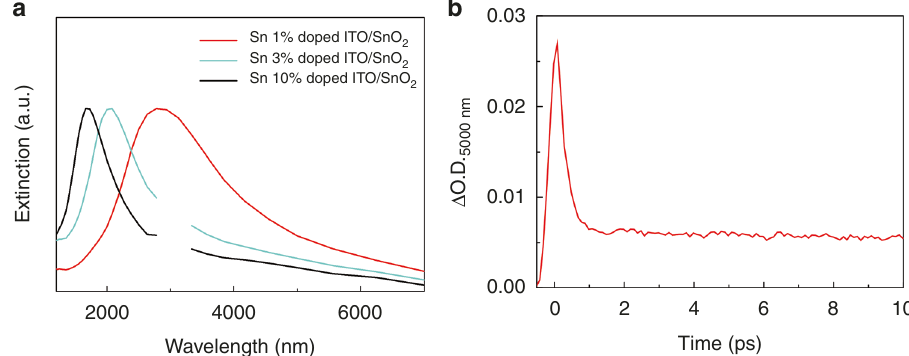
Fig. 3 Extinction spectra and kinetic pro fi les. a Extinction spectra of heterointerfaces between ITO NCs with different Sn-doping ratios and SnO 2 . The gaps at around 3000 nm of the 10%-Sn-doped ITO/SnO 2 or 3%-Sn-doped ITO/SnO 2 heterointerfaces mask noise from the instrument. b Kinetic pro fi le of the 1%-Sn-doped ITO/SnO 2 after excitation with a 2500-nm laser (6 μ J/pulse) (FWHM of IRF in the system = 285 ± 40